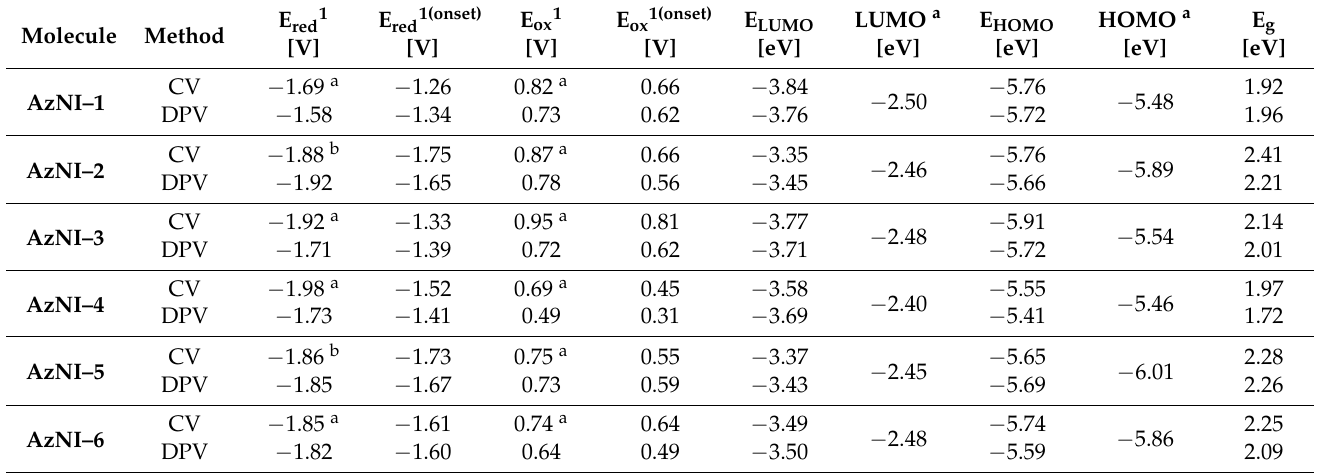
Table 2. The redox properties of the azomethino-1,8-naphthalimides.